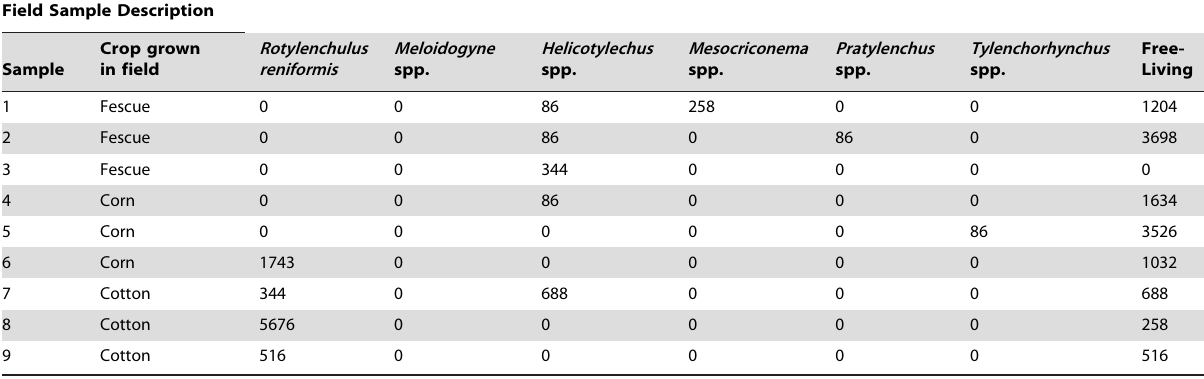
Table 3. Number of nematodes per 500 cm 3 of soil used in field assay.